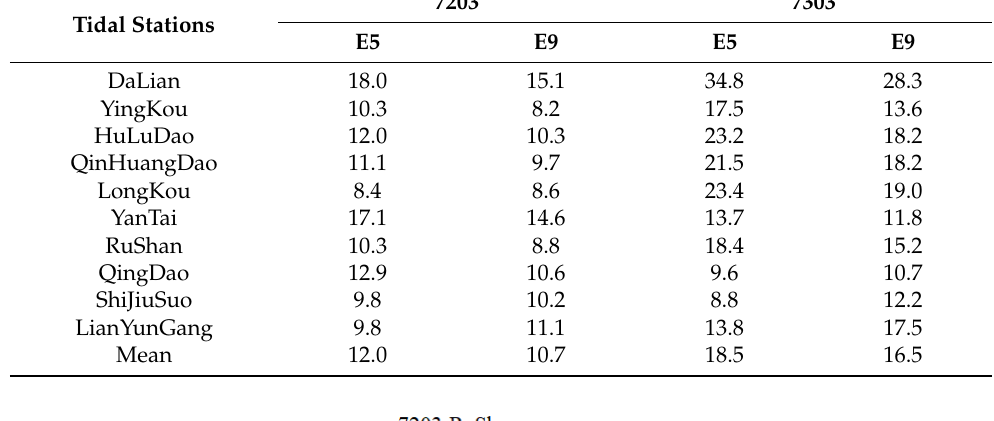
Table 11. Relative errors between simulated and observed storm surge levels at RuShan tidal sta- tion in each 6-hour period during Typhoons 7203 and 7303 (unit: %).